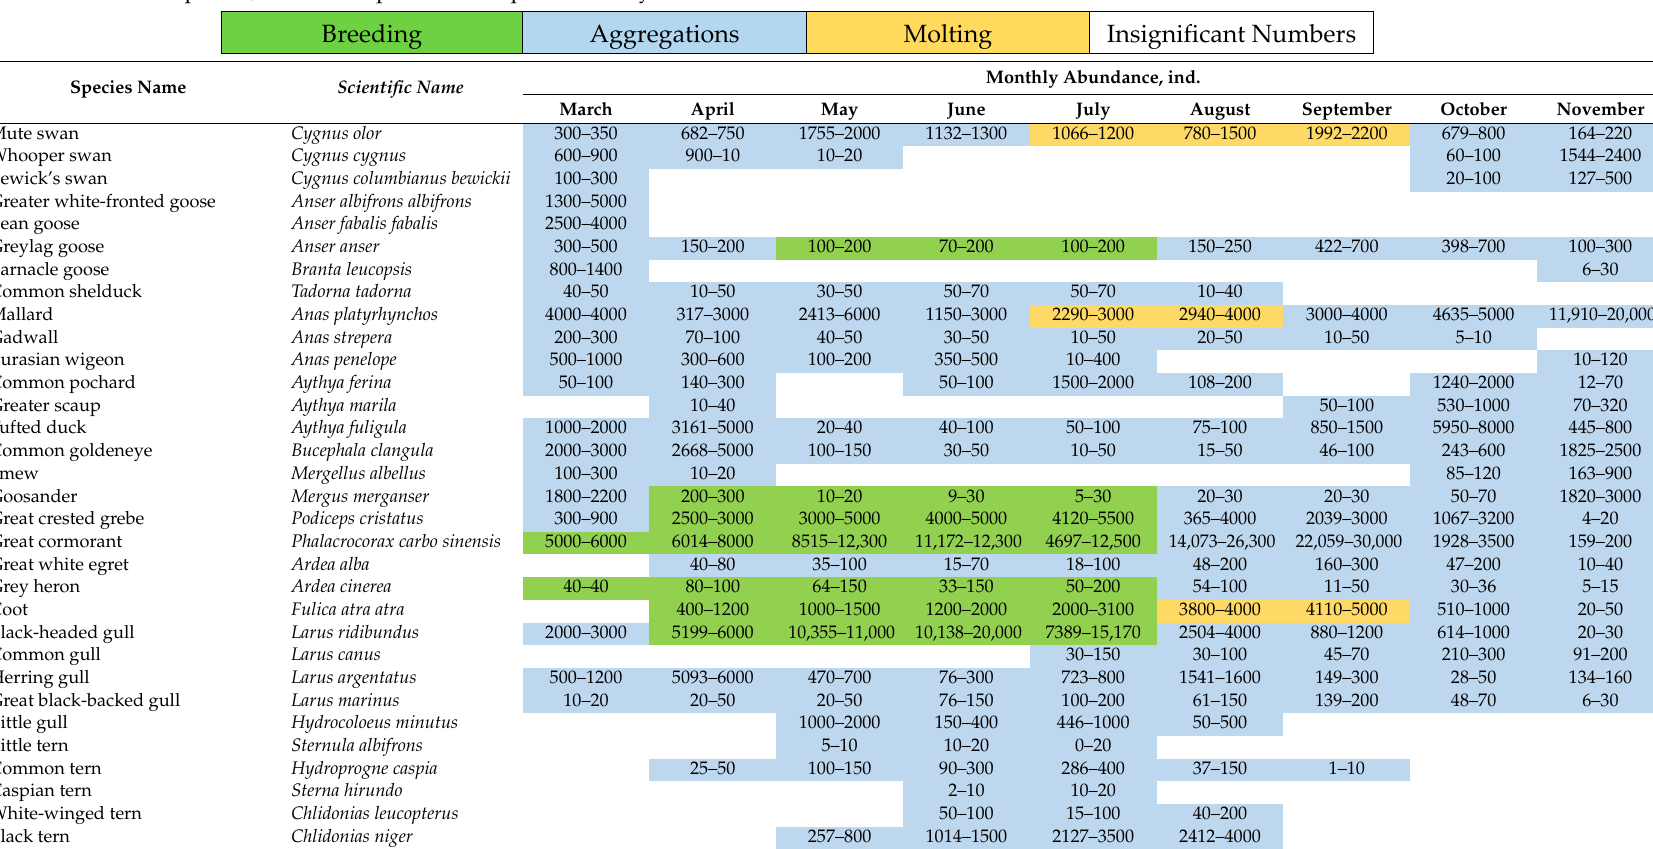
Table 1. List of the aquatic bird species censused during monthly surveys in the Lithuanian part of the Curonian Lagoon in 2018. Minimum and maximum estimated bird numbers are reported; cell color represents the species activity.